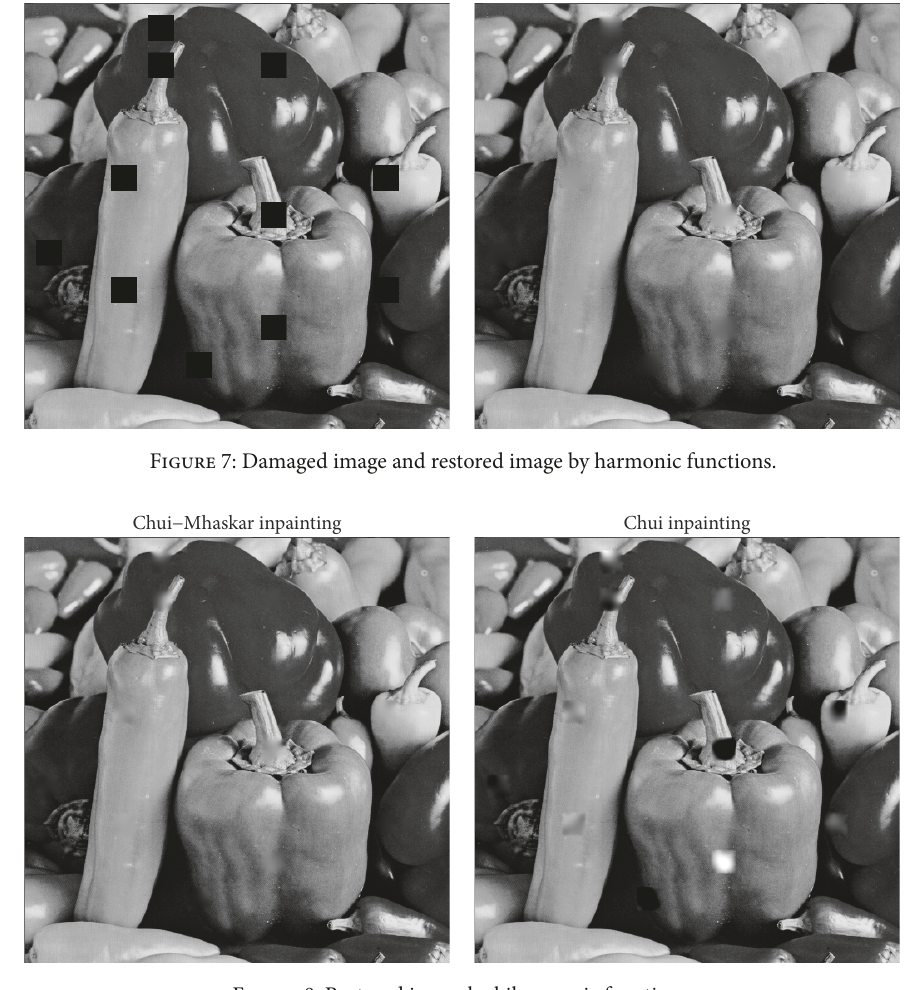
Figure 8: Restored image by biharmonic functions.